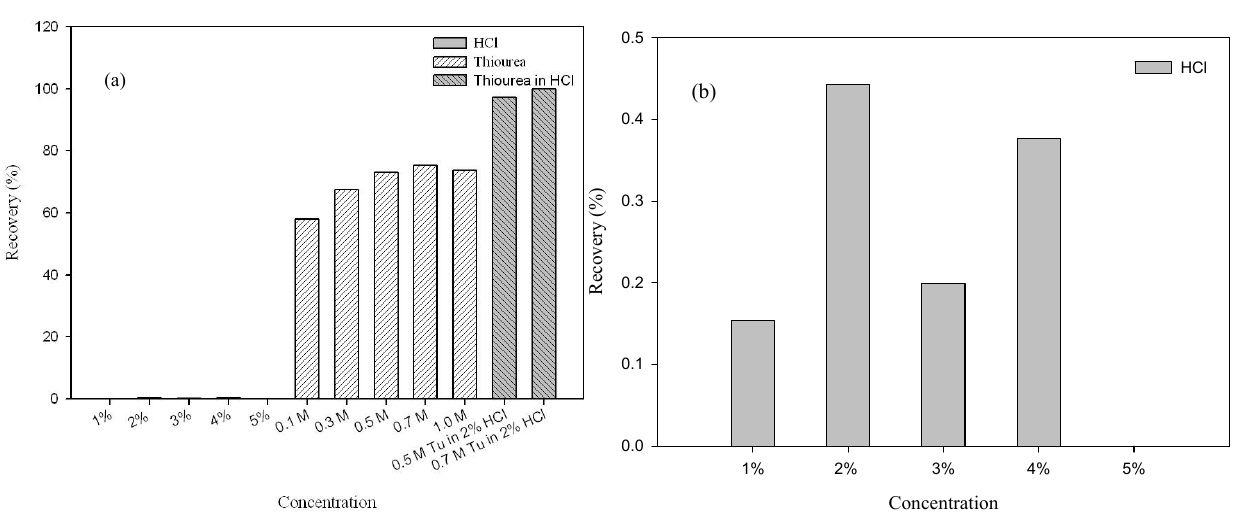
Figure 7. ( a ) Effects of various eluents and concentrations on the desorption of Au(III) from MNP-Tu; ( b ) An enlarged figure from (a) showing the concentration effects of